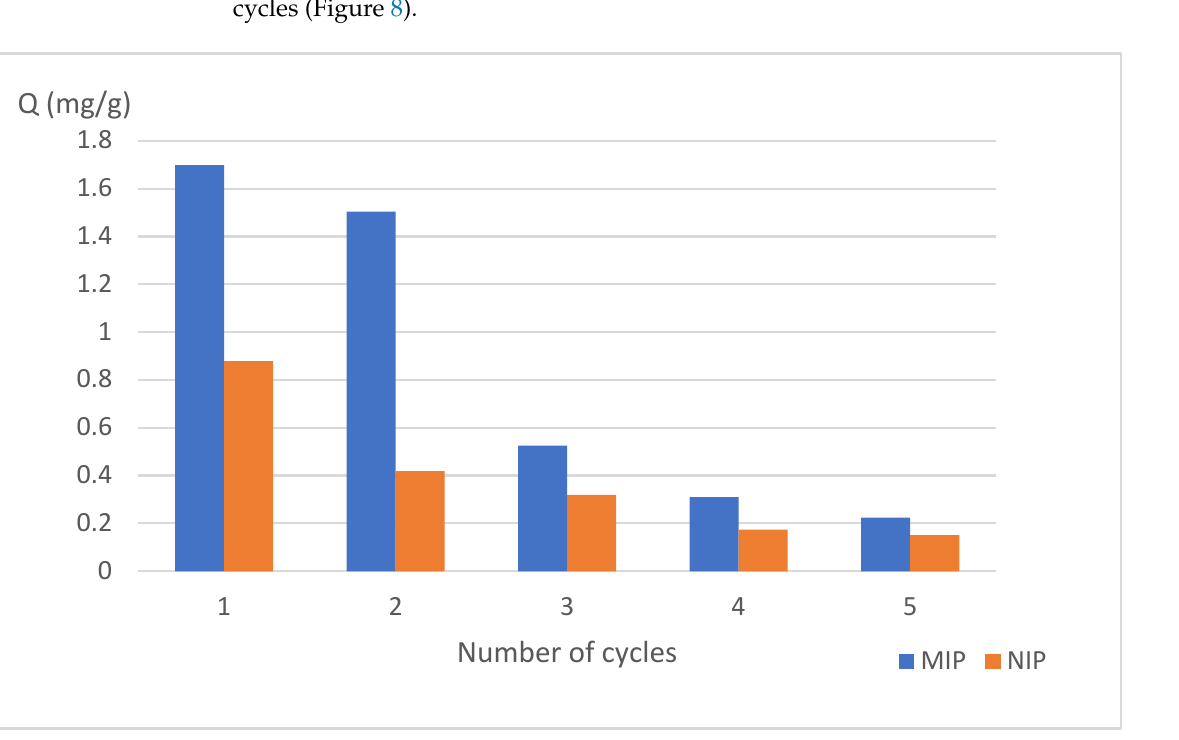
Figure 7. The adsorption capacity of MIP and NIP after undergoing five cycles isotherm adsorption studies